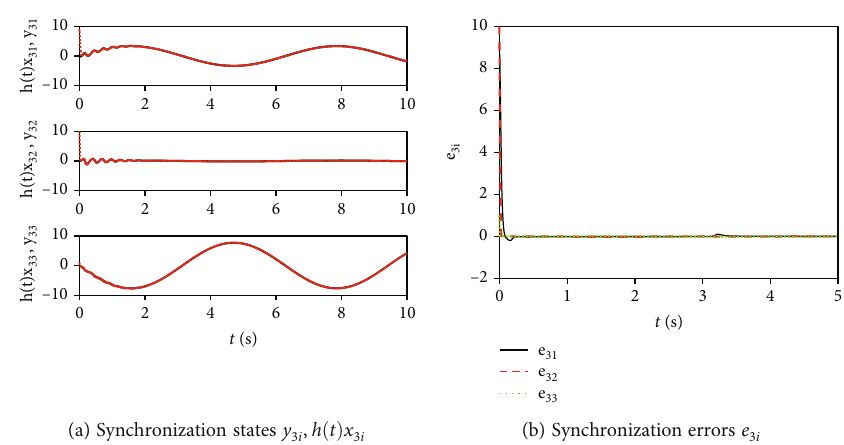
Figure 5: The time evolution of synchronization between y